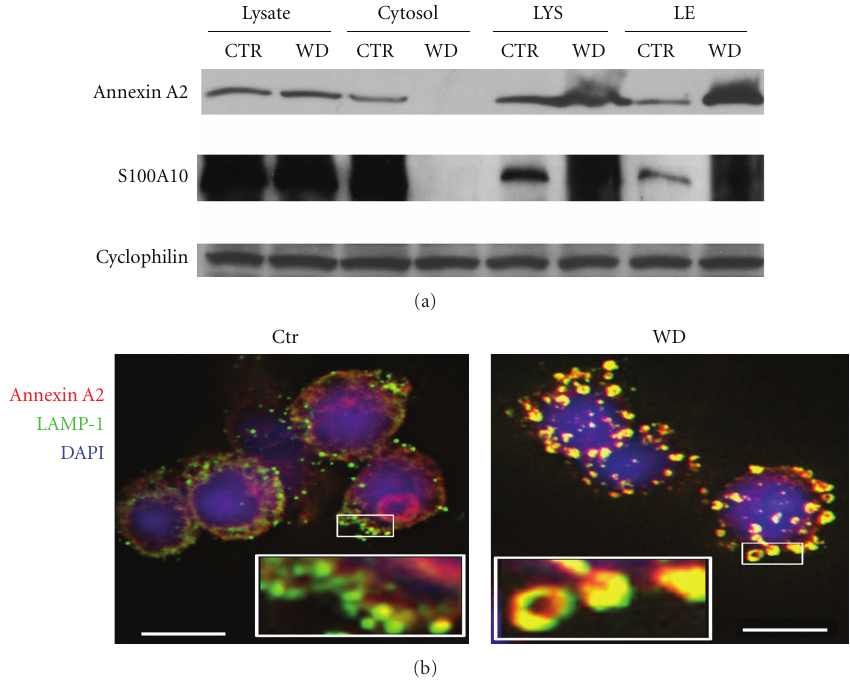
Figure 5: Intracellular A2 redistributes to lysosomal and late endosomal membranes in dendritic cells upon endocytosis of wear debris particles (WDP). (a) Western blot analysis of A2 and p11 localization in late endosomes (LE) and lysosomes (LYS) isolated from WDP- treated dendritic cells. (b) Confocal analysis of untreated and 12 h WDP-treated dendritic cells stained with anti-LAMP1 (green) and anti-A2 (red) revealed well-delineated LAMP + endosomal compartments with cytosolic distribution of A2 in control cells. Cells cultured with WDP for 12 h (b) demonstrated an extensive increase in the number and size of the endosomal compartments with the subsequent loss of the cytosolic distribution of A2. Bar corresponds to 10mm. Reproduced with permission